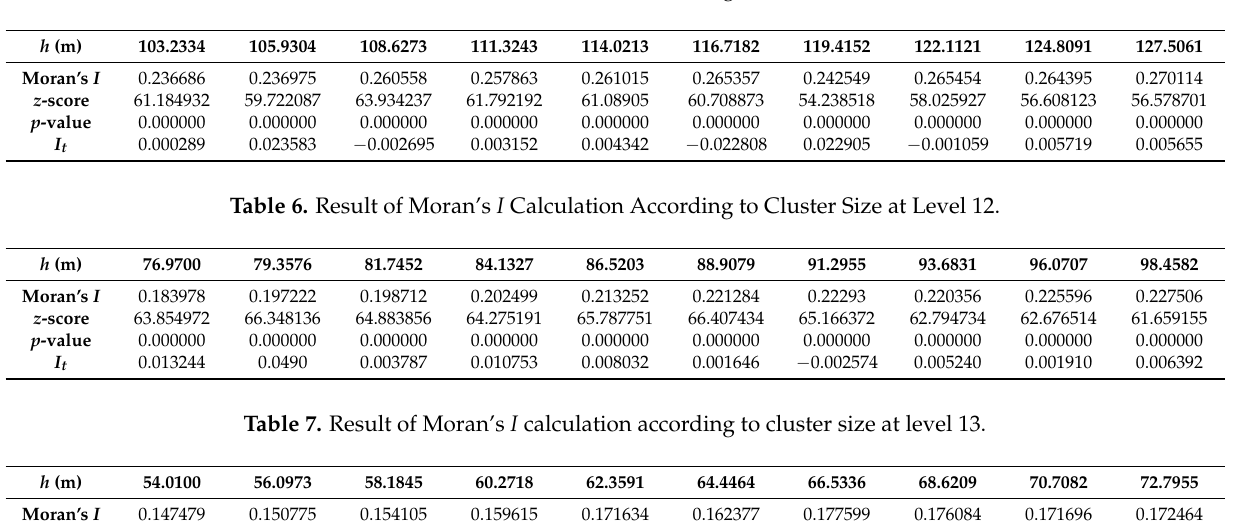
Table 5. Result of Moran’s I calculation according to cluster size at level 11.